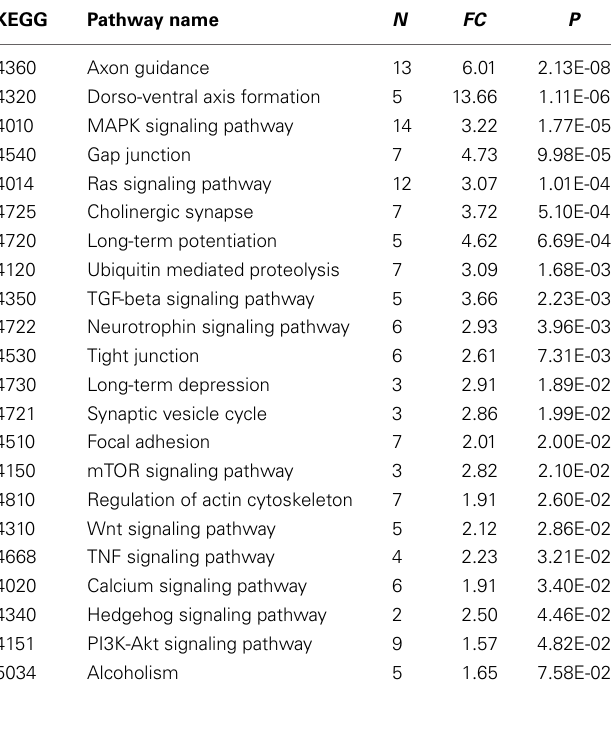
Table A3 | Neural related pathways enriched in targets with increased activity-dependent Ago2 association.